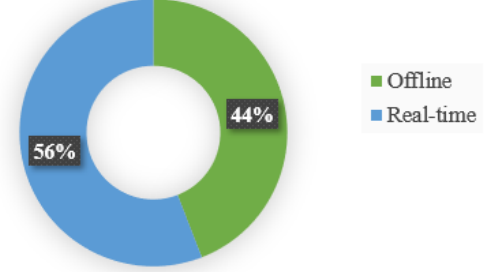
Figure 13. Offline/real-time implementation of the decision-making